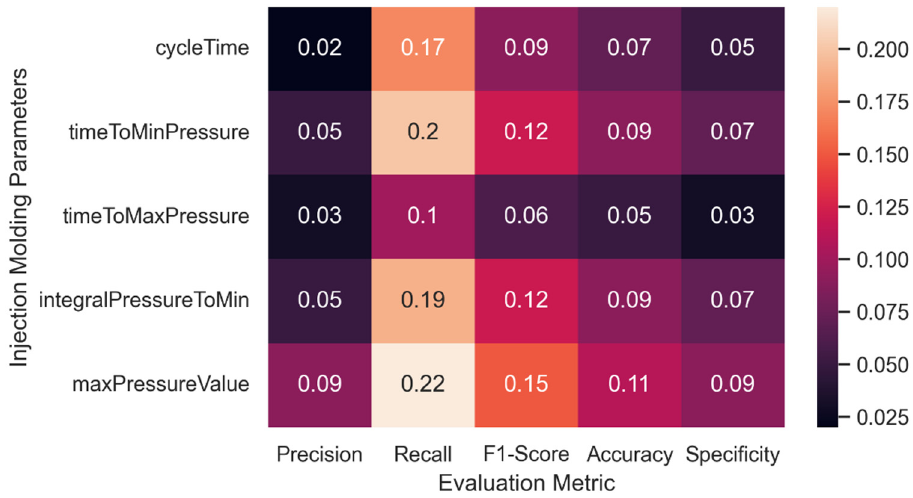
Figure 10. The comparison of extracted important parameters toward model performance.